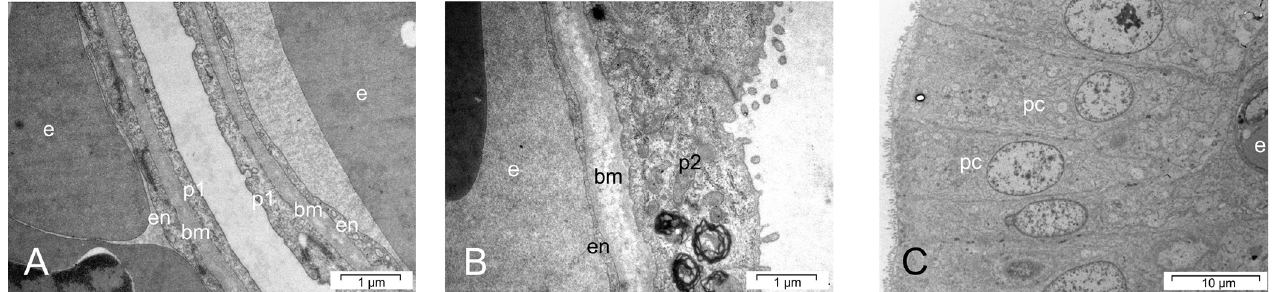
Fig 9. Sections of a lung, transmission electron microscopy of the air-blood barrier. (A) Score 0, snake No. C4, day 4. Demonstration of normal air-blood barrier. (B) Score 1, snake No. C5, day 16. Demonstration of an increasing thickness of the basal lamina and the epithelium. (C) Score 2, snake No. B8, day 28. Transformation of the epithelium into high prismatic cells and massive increase of the air-blood-barrier. (bm = basal lamina, en–endothelium, e–erythrocyte; p1—type-I pneumocyte; p2—type-II pneumocyte, pc = high prismatic transformed epithelial cell).